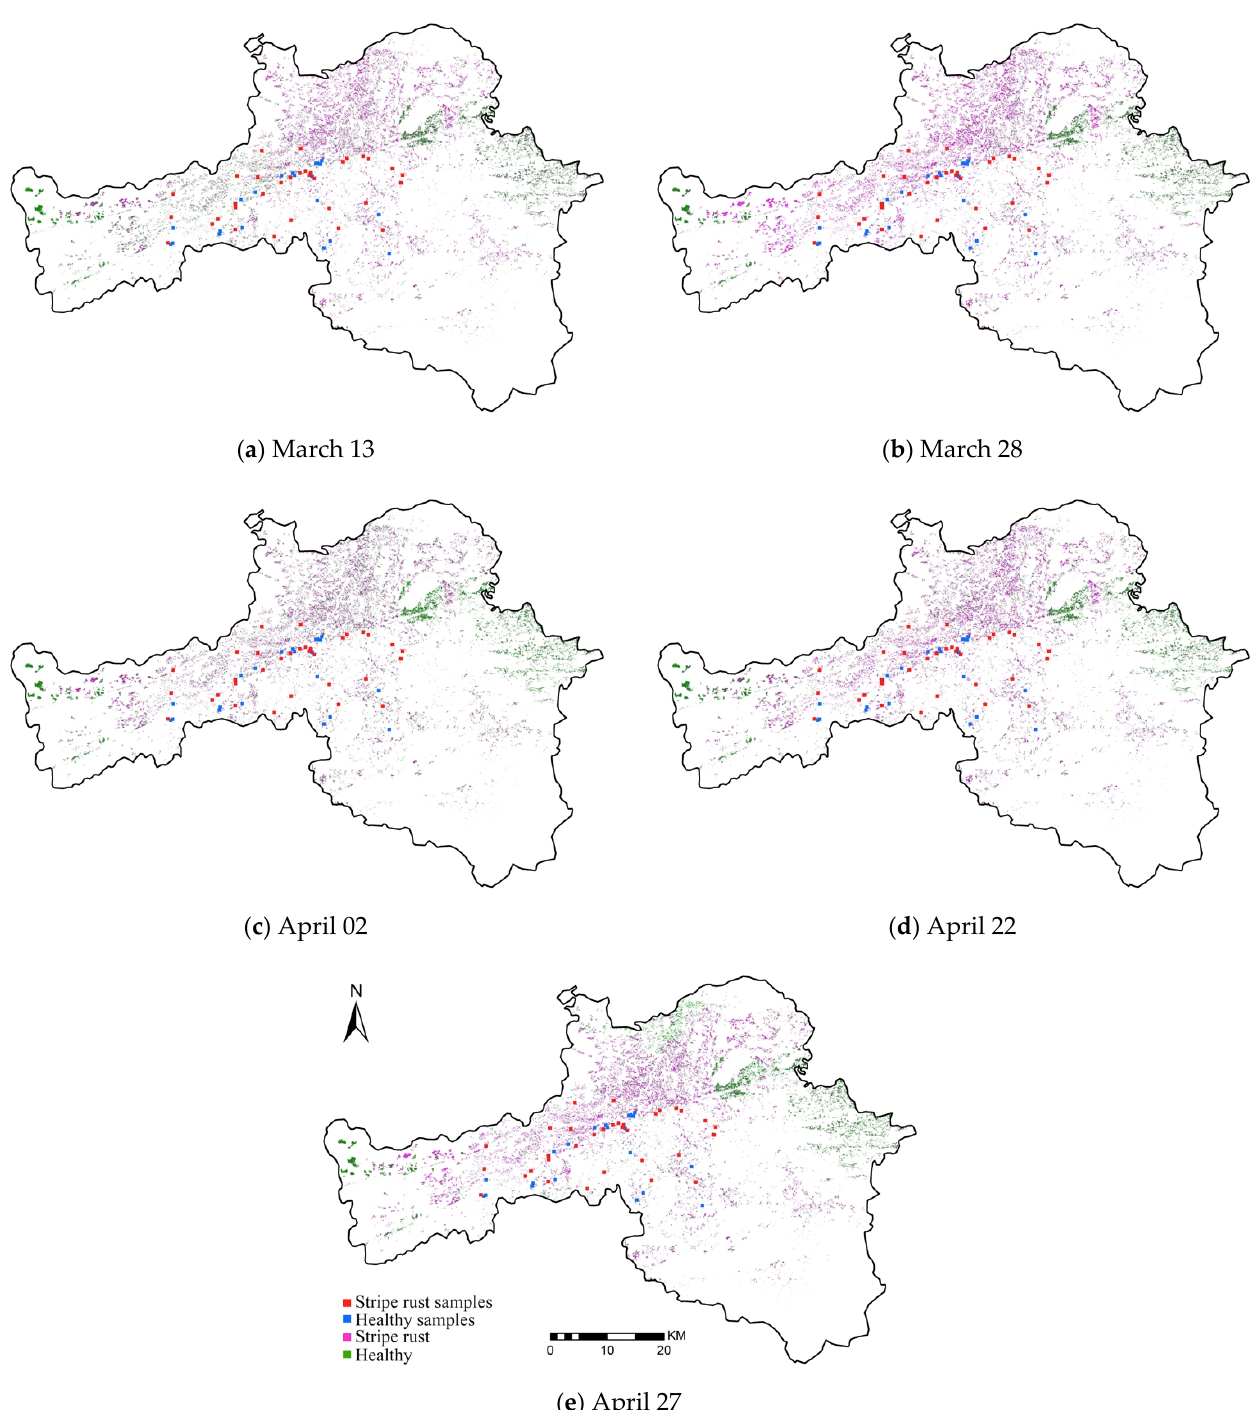
Figure 6. Predicting and mapping of wheat stripe rust in Ningqiang County on ( a ) March 13; ( b ) March 28; ( c ) April 02; ( d ) April 22; and ( e ) April 27, based on the support vector machine (SVM) method using the optimal vegetation indice combinations. Red represents stripe rust samples, blue represents healthy wheat samples, pink represents stripe rust-infested wheat, and green represents healthy wheat.